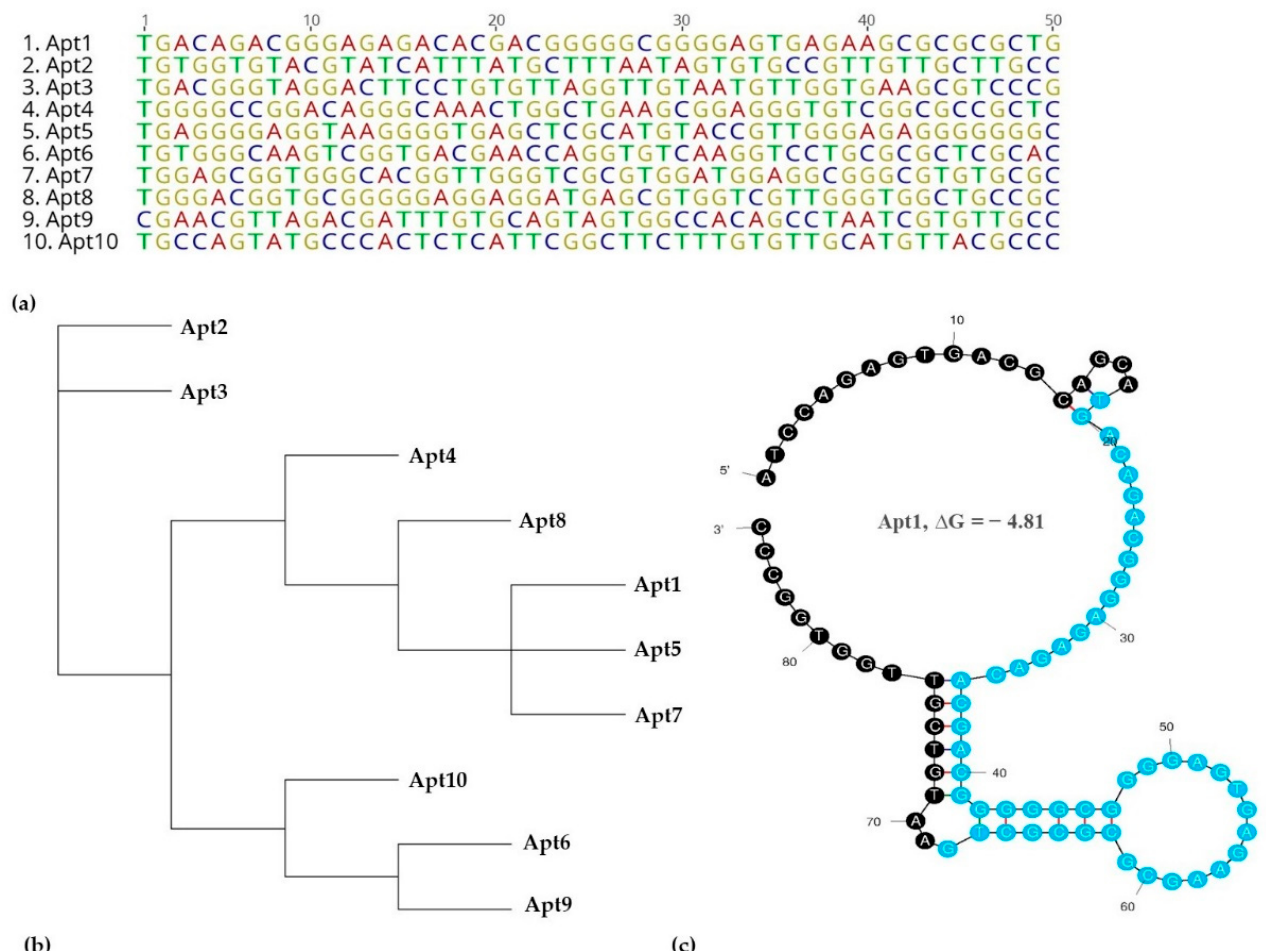
Figure 3. Primary structure, phylogenetic tree and secondary structure of the selected aptamers: ( a ) Multiple sequence alignments of the random region from the ten most repeated oligonucleotide sequences obtained after NGS. ( b ) Phylogenetic analysis of the ten aptamer sequences was deter- mined using the Tree Builder function in Geneious software. ( c ) Predicted secondary structure for aptamer candidate Apt1 that was selected for further in vitro characterization experiments. The pre- sented predicted secondary structure was the one with lowest Δ G, i.e., the highest stability using the temperature 37 °C, 137 mM Na + , and 1.4 mM Mg 2+ , as calculated using the mfold web server. The randomized region is presented in blue.